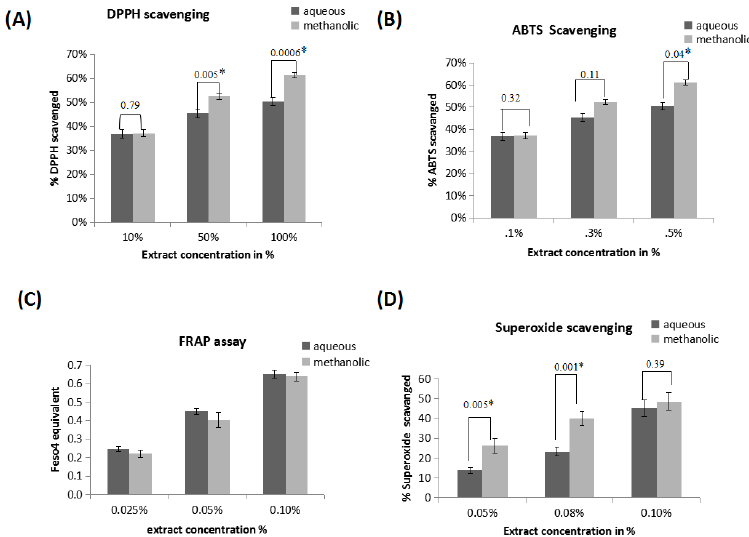
Figure 2. In vitro radical scavenging assays for different concentrations of aqueous and methanolic extracts of A. catechu. ( A ) DPPH radical scavenging activity of 10%, 50% and 100% aqueous and methanolic extracts of A. catechu was expressed in terms of % scavenged using ascorbic acid as a standard. ( B ) 2,2 (cid:48) -Azinobis-(3-ethylbenzothiazoline-6-sulfonic acid) (ABTS • + ) radical scavenging activity of 0.1%, 0.3% and 0.5% aqueous and methanolic extracts of A. catechu in terms of % ABTS scavenged. ( C ) Ferric reducing antioxidant power of 0.025%, 0.05% and 0.1% aqueous and methanolic extracts of A. catechu in terms of FeSO 4 equivalents. ( D ) Superoxide radical (SOD • + ) radical scavenging assay of 0.1%, 0.3% and 0.5% aqueous and methanolic extracts of A. catechu in terms of ascorbic acid equivalents concentrations. * Statistically significant ( p ≤